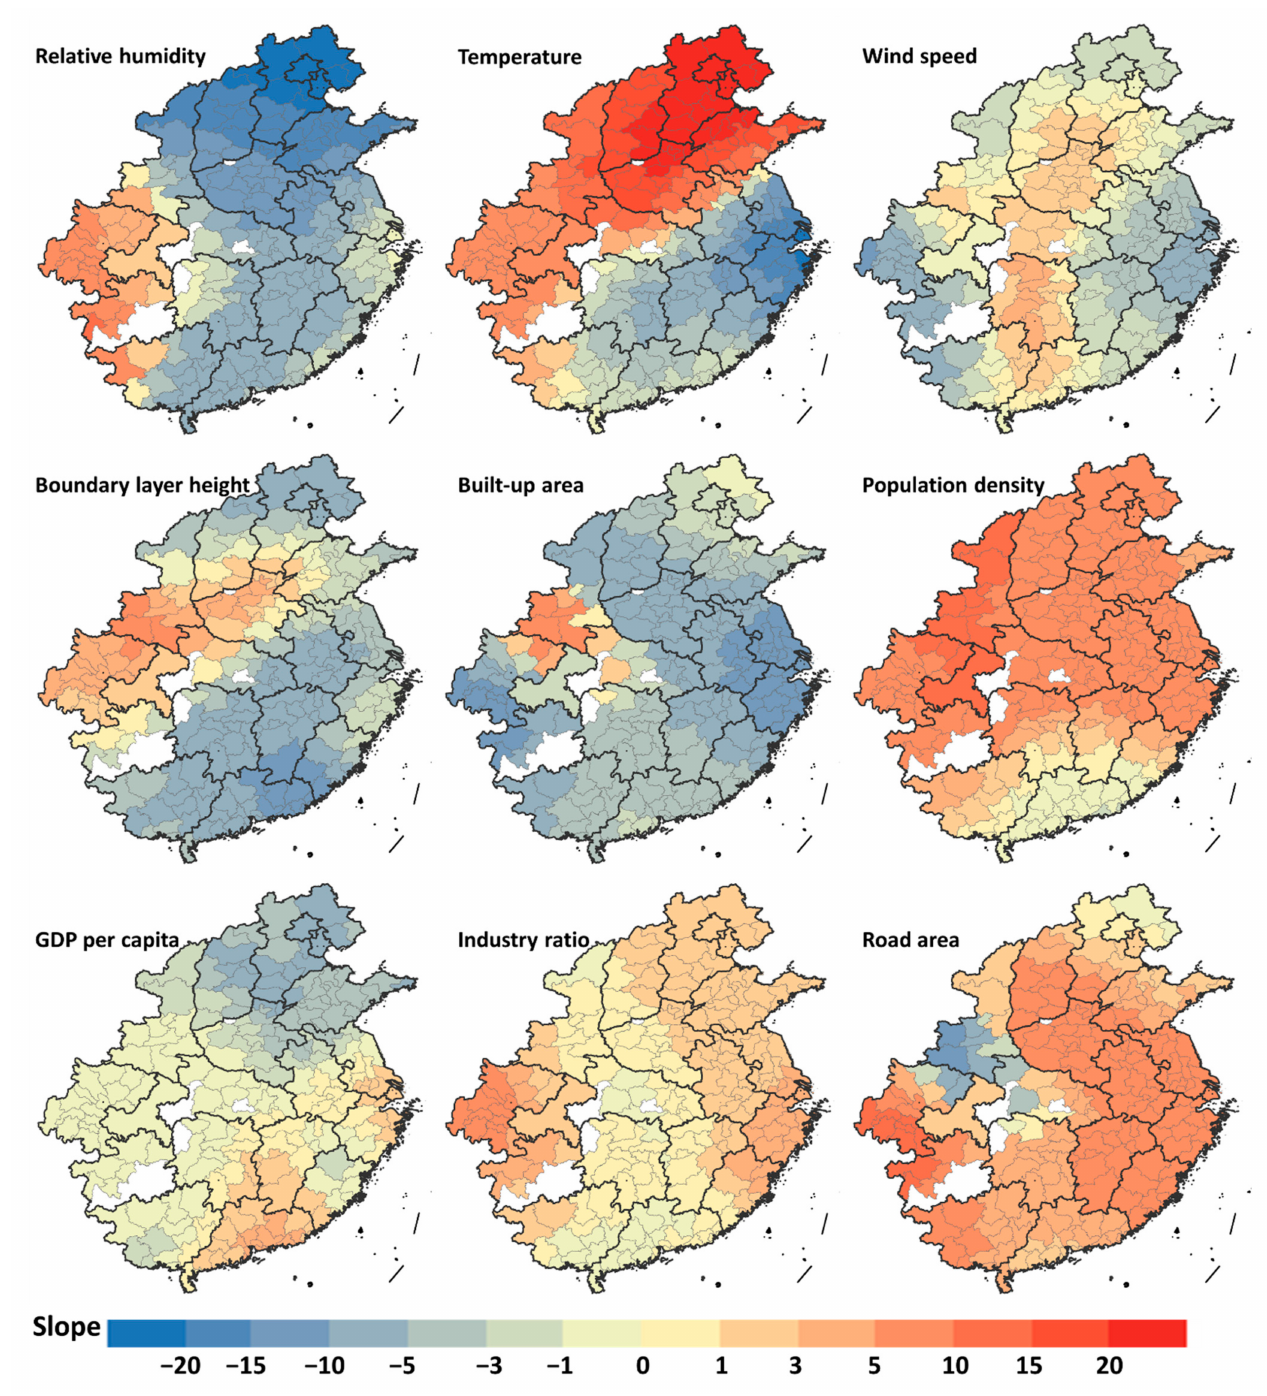
Figure 7. The space-varying coefficients of GWR models for each influencing factor based on the average data from 2001 to